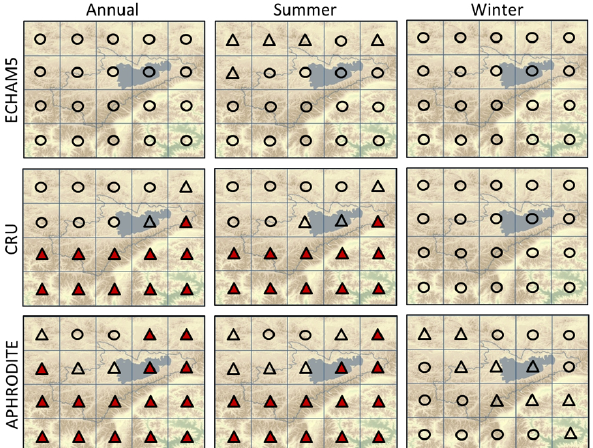
Fig. 7. Mann-Kendall trend test results for annual, summer and winter precipitation of ECHAM5 (top), CRU (middle) and APHRODITE (bottom) for the period 1981–2004 ( 4 /red 4 = sig- nificant/highly significant increasing trend with p = 80%/95%; (cid:13) = no significant trend).